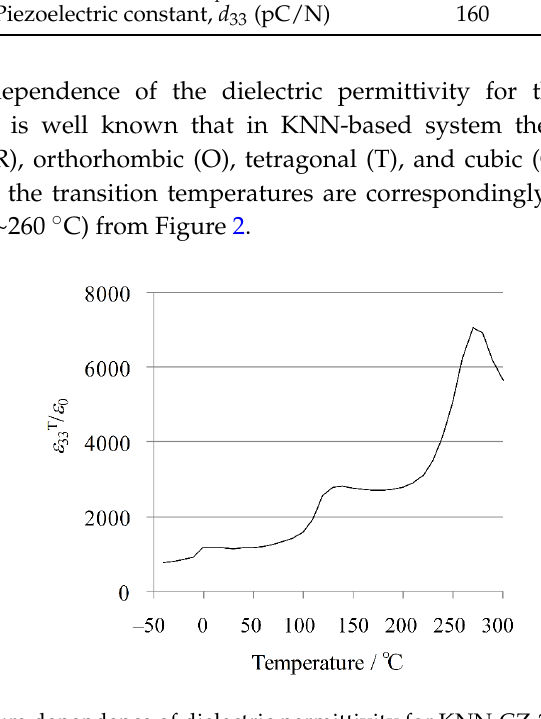
Figure 3. Optical microscope image of cross section of multilayer KNN ‐ CZ ‐ 2 ceramic structure.